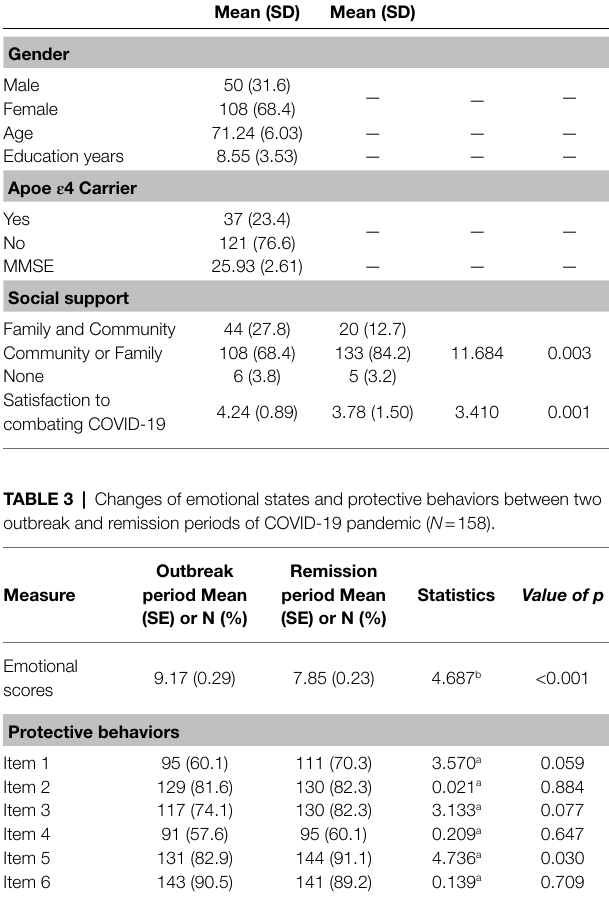
Apoe ε 4 Carrier